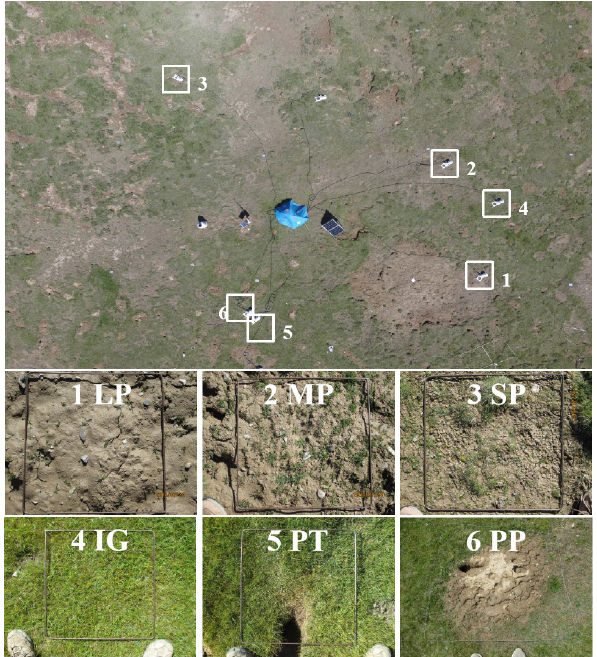
Figure 1. An aerial photo of field observation of ecosystem respira- tion at six surface types: (1) large bald patch (LP), (2) medium bald patch (MP), (3) small bald patch (SP), (4) intact grassland patch (IG), (5) above pika tunnel (PT) and (6) old Pika pile